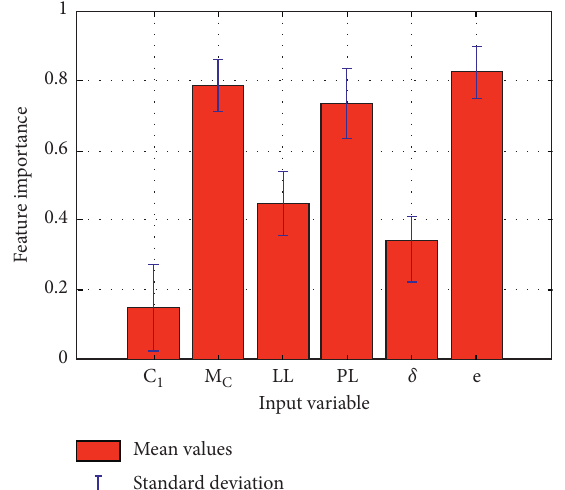
Figure 11: Out-of-bag feature importance calculated using RF